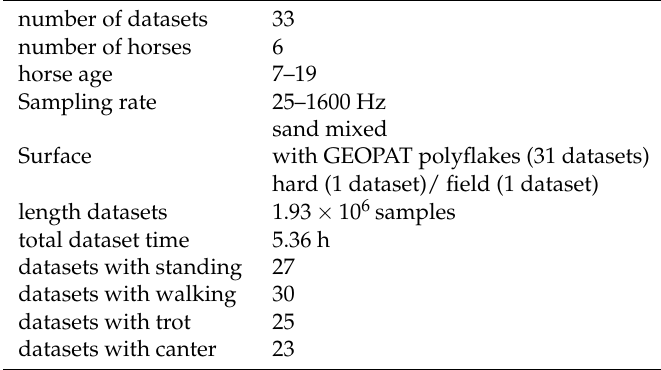
Figure 2. The collected datasets have different relative distributions for the different gaits. The majority of the datasets contains data for the horse in the four different natural gaits (Stand, Walk, Trot and Canter). Some of the datasets capture other types of movement (rolling: datasets 30, 32 and 33; pawing: dataset 18 and flank-watching: dataset 24). Table 1. For this study, 33 datasets have been collected. The different properties of the datasets allow to study the impact of different environmental